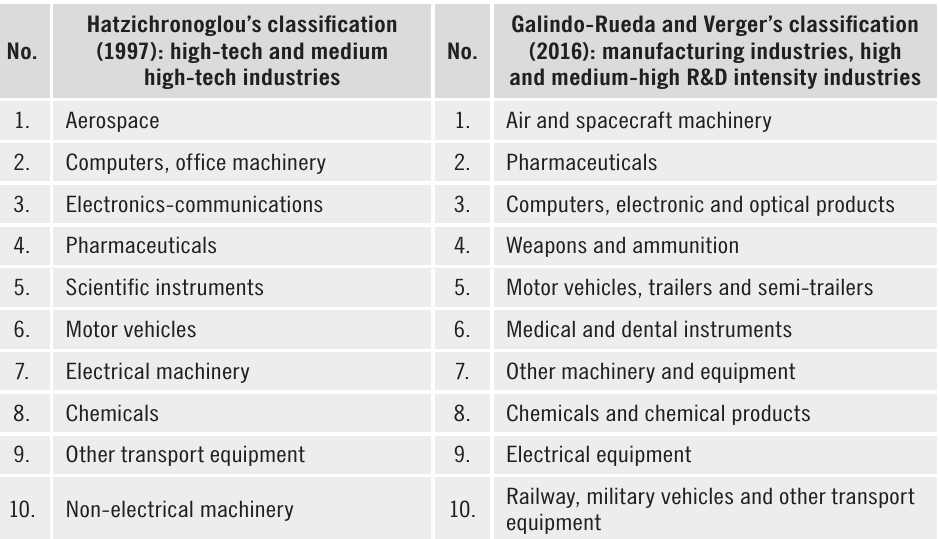
Table 1. Elements of Hatzichronoglou’s (1997) and Galindo-Rueda and